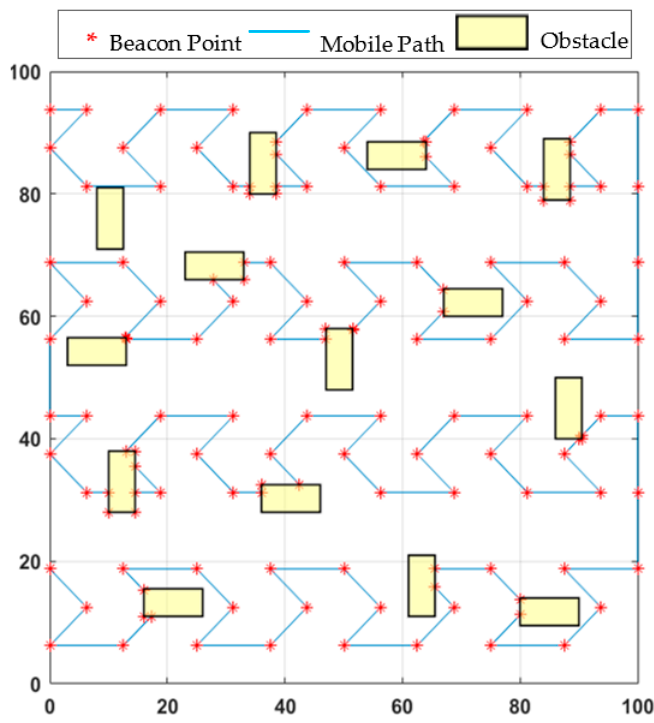
Figure 9. NHexCurves in obstacle-handling trajectory.